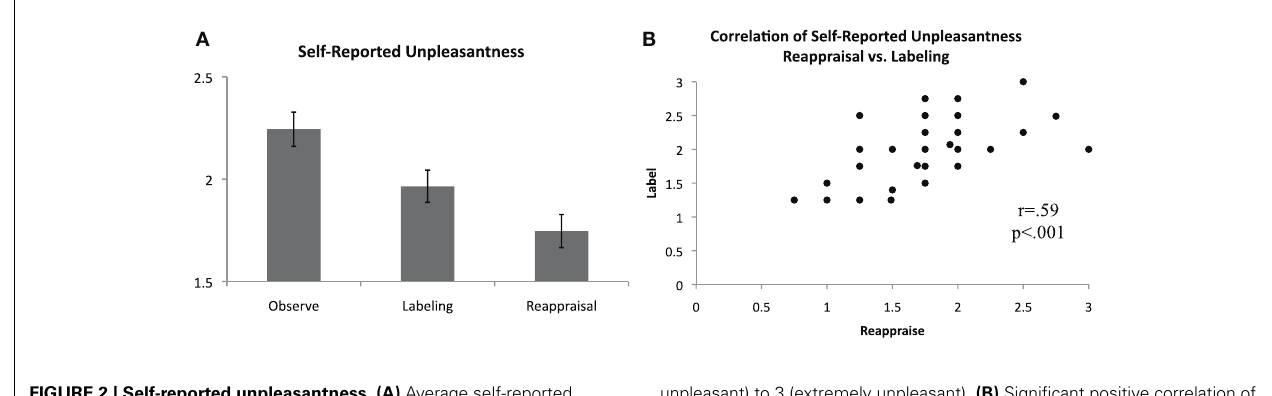
FIGURE 2 | Self-reported unpleasantness. (A) Average self-reported unpleasantness, as rated immediately following blocks of passive observation, affect labeling, and reappraisal, on a scale from 0 (not at all